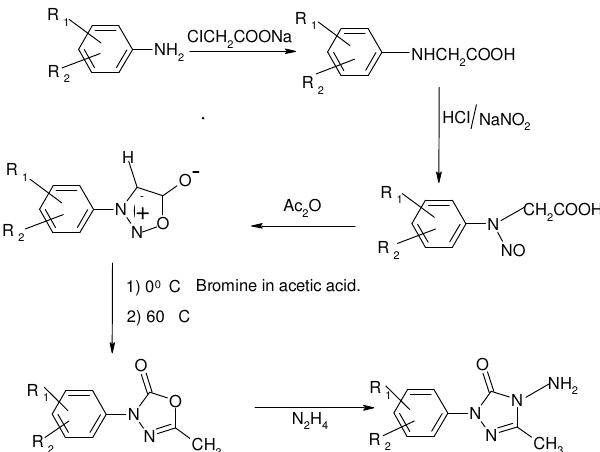
Figure 1. Systematic scheme for preparation of 3-aryl sydnones, oxadiazolines and triazoles. Synthesis of 7-hydroxy-4-methyl coumarin